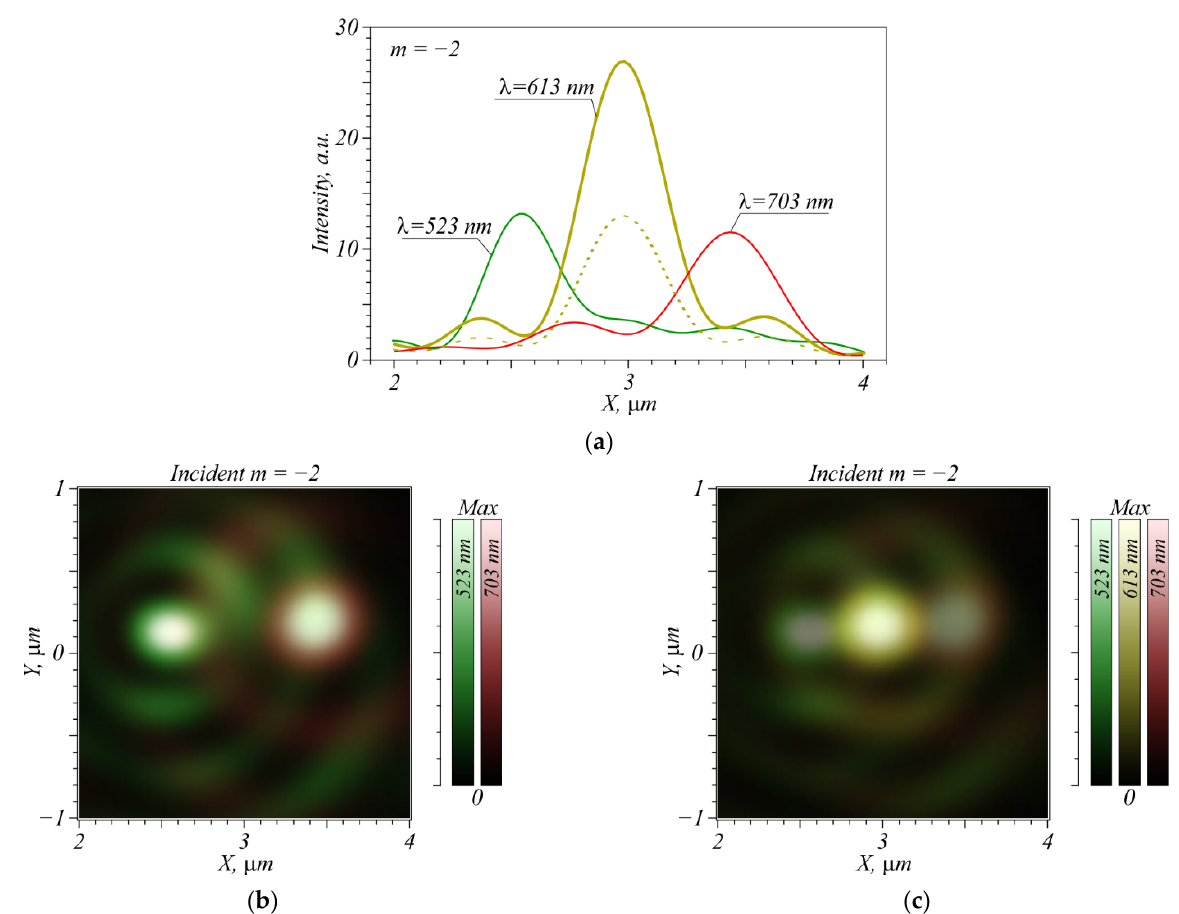
Figure 5. Profiles of intensity maxima of a focused vortex with TC m = − 2 for three wavelengths: λ = 523 nm, 613 nm, and 703 nm ( a ), simultaneous location in the focal plane of two ( b ) and three ( c ) focused vortices in accordance with their relative intensities. The dotted line in ( a ) shows the atten- uation of the 613 nm intensity at which all three vortices can be successfully resolved in any combi- nation with a sufficient contrast.